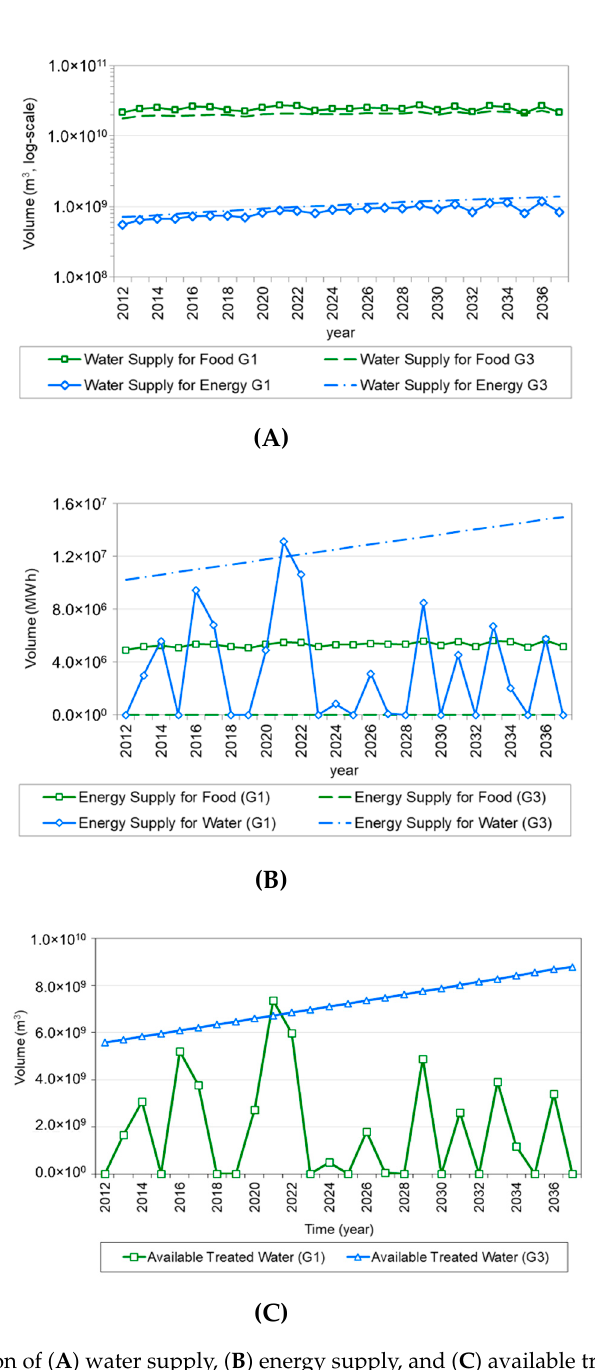
Figure 9. Comparison of ( A ) water supply, ( B ) energy supply, and ( C ) available treated water between Group 1 and Group 3.